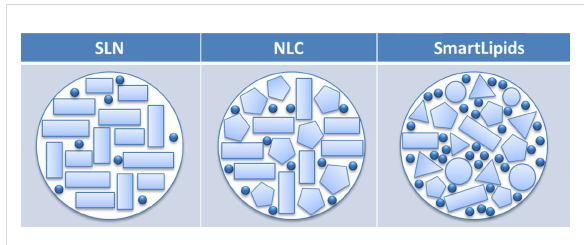
Figure 1: Simple representation of the structure of SmartLipids. The mixture of structurally very different solid and liquid lipids leads to a chaotic, less ordered structure ( α , β′ ) with many imperfections, provid- ing high loading capacity. The structure remains unchanged during storage leading to a firm inclusion of active agents with chemical stabi- lization and no expulsion of the active agents [10].